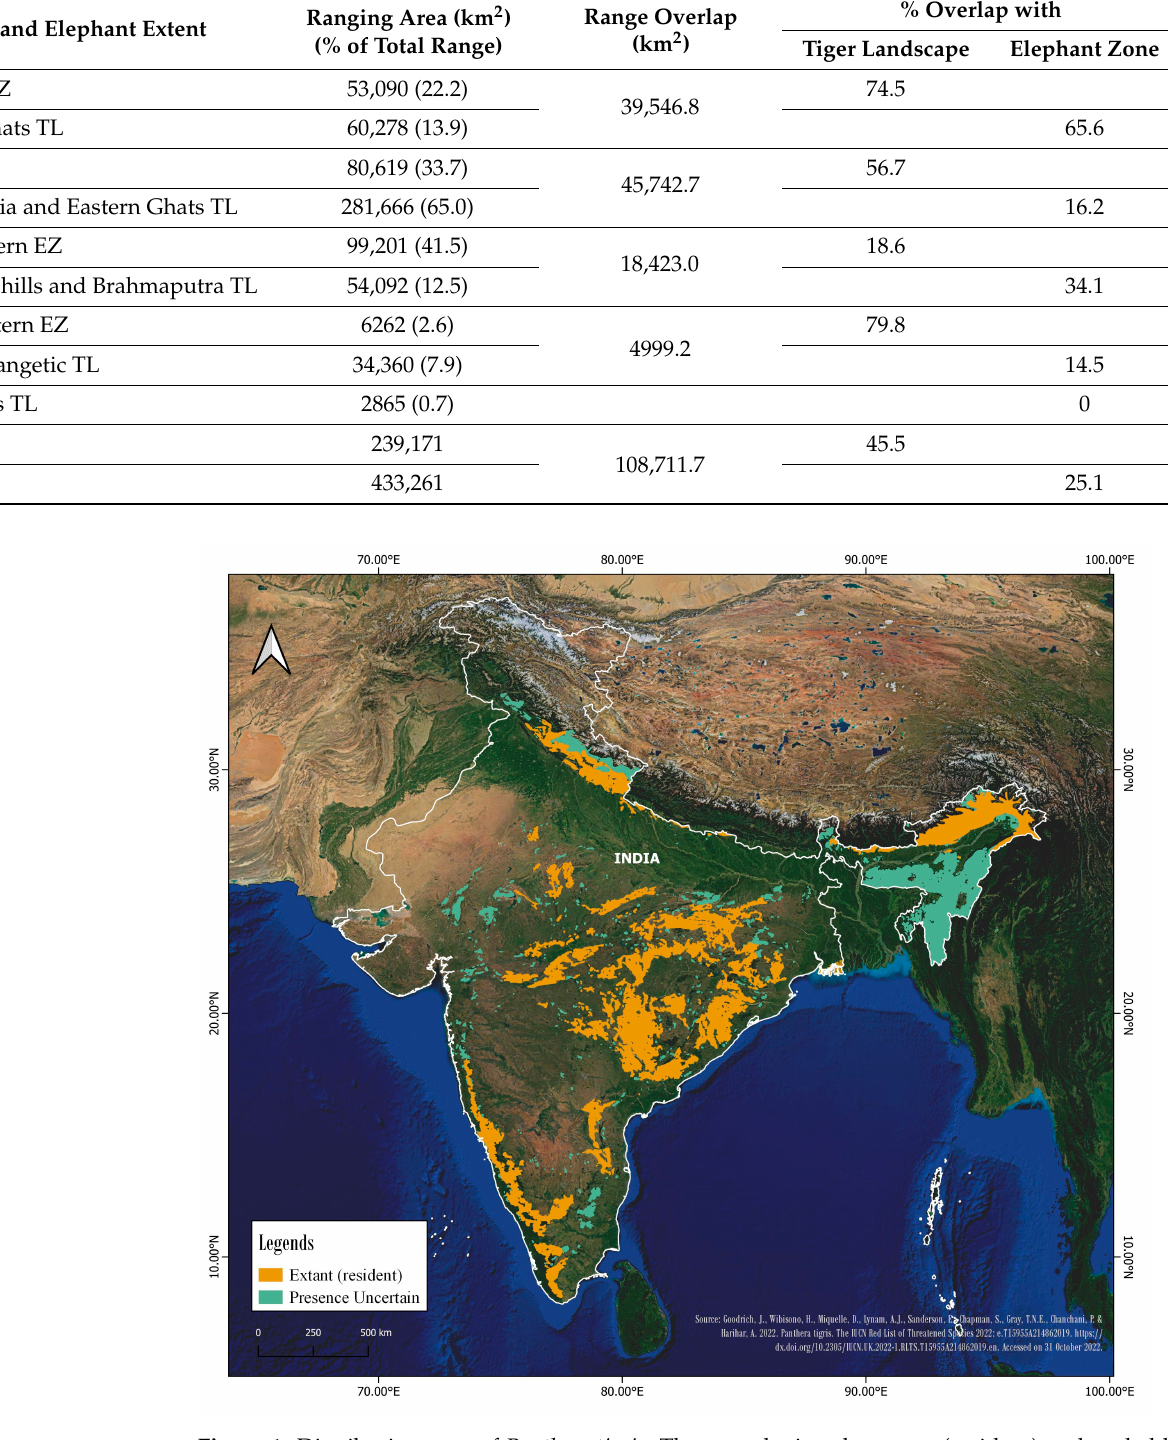
Figure 1. Distribution map of Panthera tigris : The map depicts the extant (resident) and probable distribution ranges of Panthera tigris as per Goodrich et al.